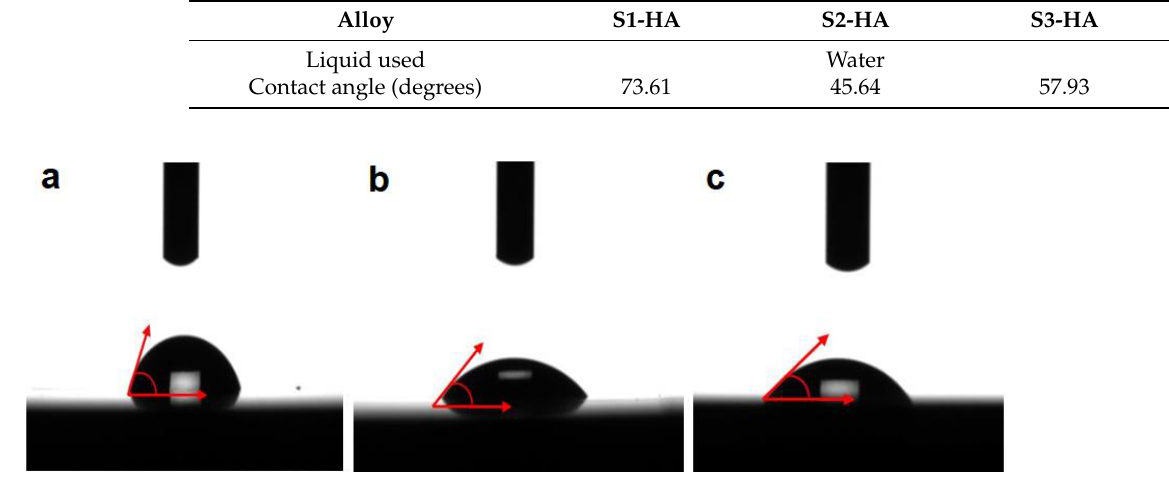
Figure 7. Images of the water drop on the surface of the alloys: ( a ) S1-HA, ( b ) S2-HA, ( c )